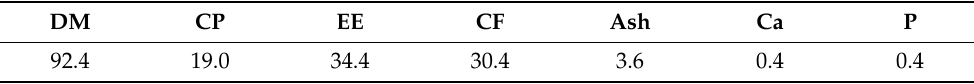
Table 1. Chemical composition on full-fat almond